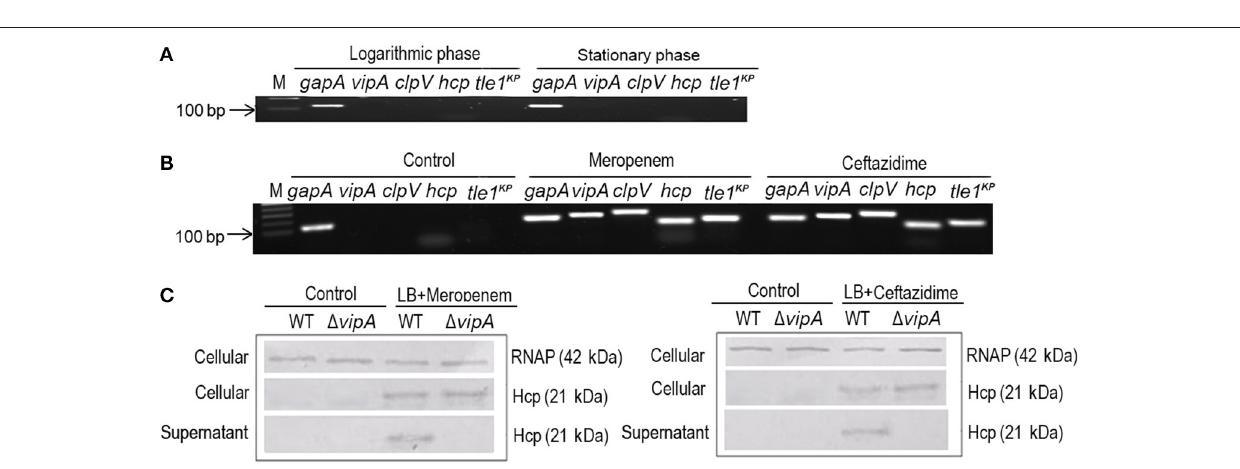
such as temperature, pH, and the presence of chitin